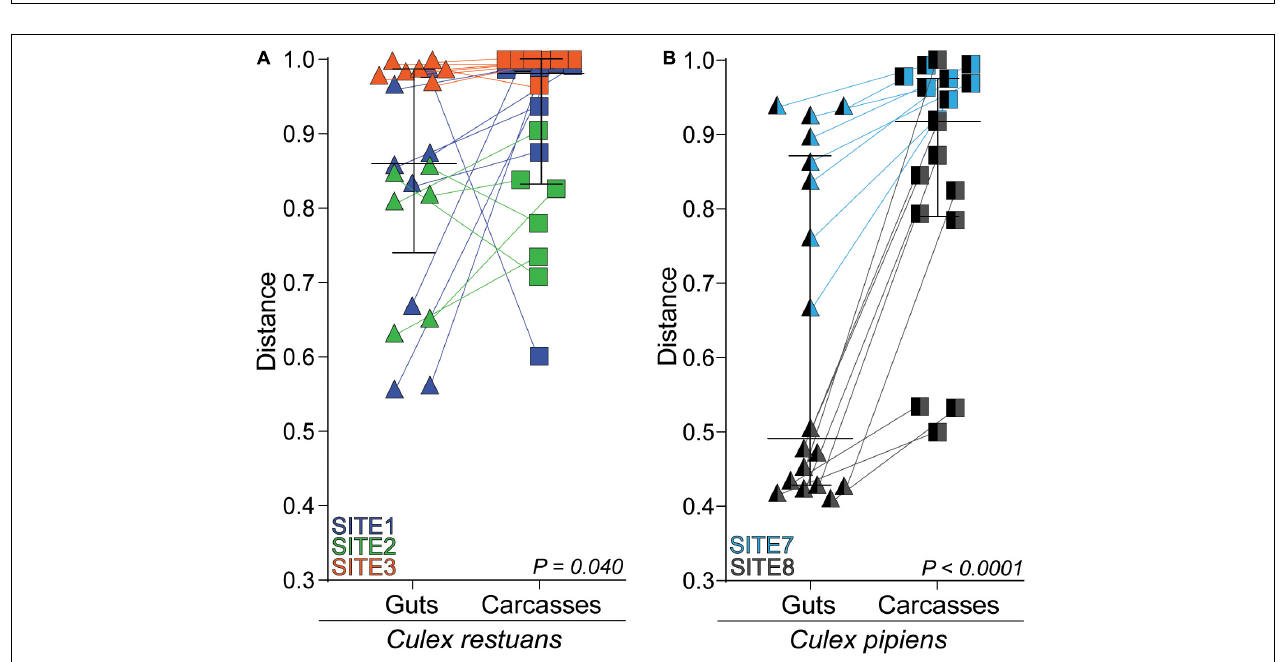
FIGURE 4 | Bray-Curtis dissimilarity distances of fungal communities from the breeding water to larval guts vs. larval carcasses across all breeding sites. (A) Bray-Curtis distances for Cx. restuans guts and carcasses. (B) Bray-Curtis distances for Cx. pipiens guts and carcasses. Connecting lines shows matched individual mosquito gut and carcass samples. Statistical significance is inferred by a Wilcoxon signed-rank